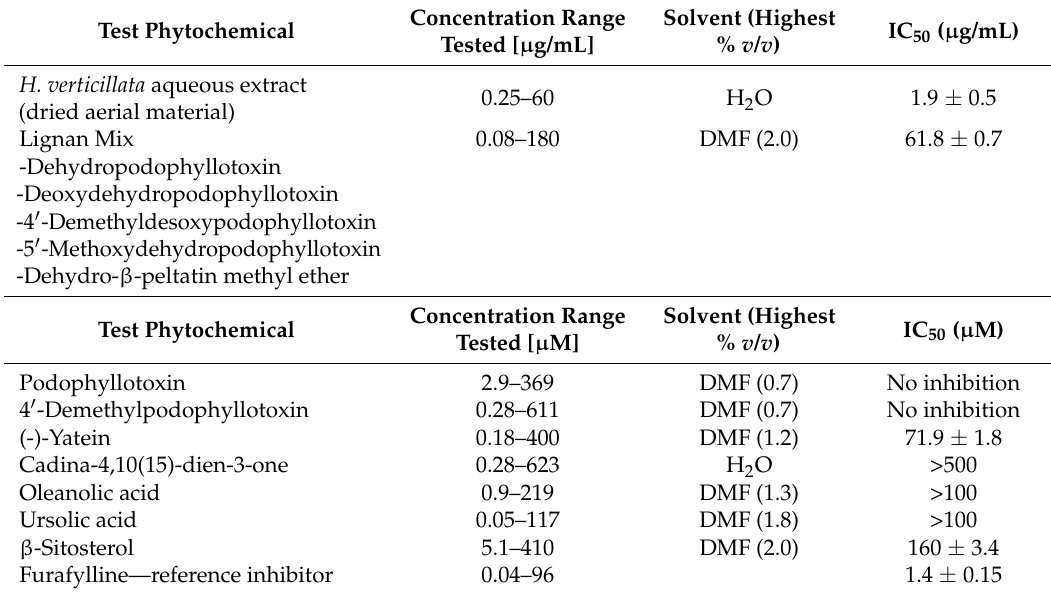
Table 2. IC 50 values of the aqueous extract of H. verticillata and key phytochemicals and their impact on metabolism mediated by